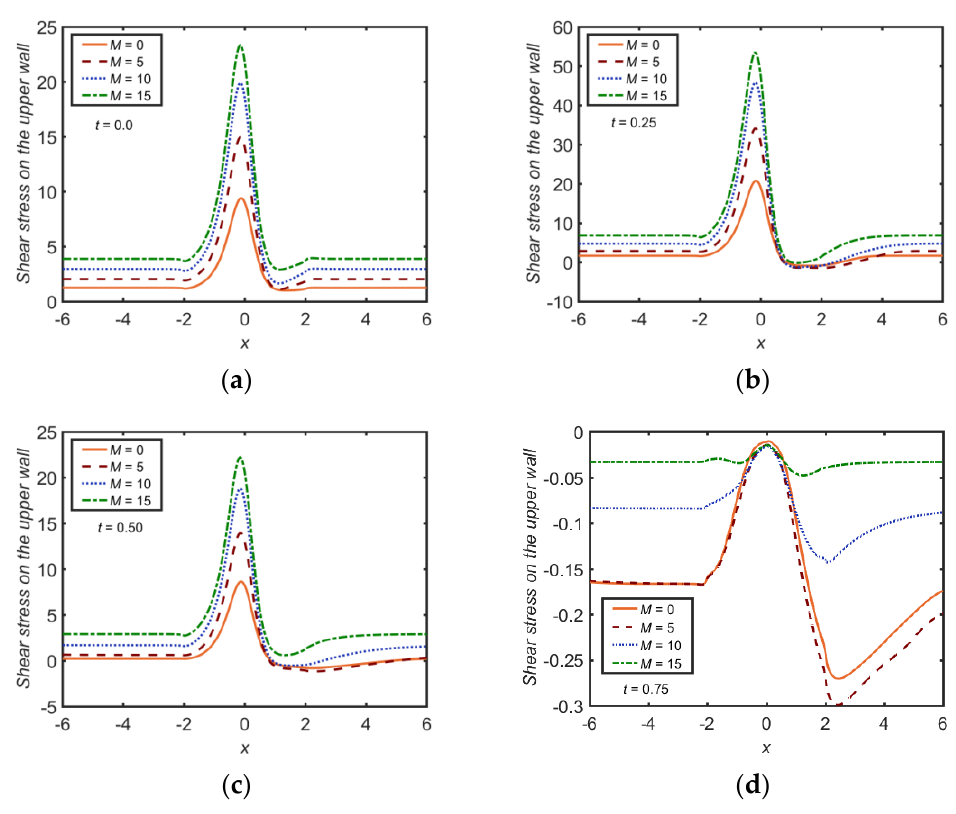
Figure 4. The WSS distribution on varying the values of M with St = 0.02, Re = 700, and K = 0.6 at ( a ) t = 0, ( b ) t = 0.25, ( c ) t = 0.50, and ( d ) t = 0.75. The WSS on the upper wall in a pulsatile cycle at different times for St = 0.02, 0.04, 0.06, and 0.08 with M = 5, K = 0.6, and Re = 700 is shown in Figure 5. During 0 < t <